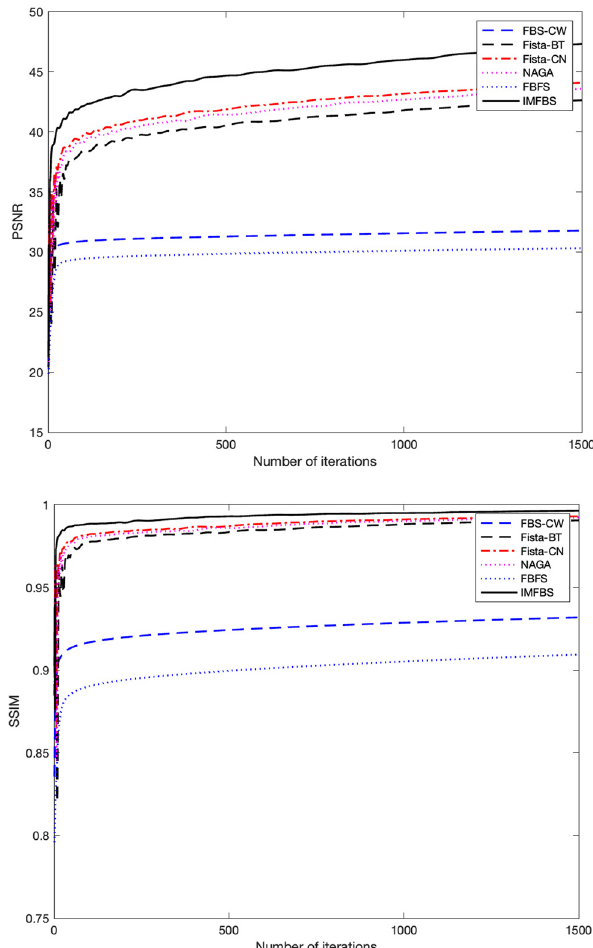
Figure 7: Graphs of PSNR and SSIM for FIG ( A ) by Gaussian blur matrices,